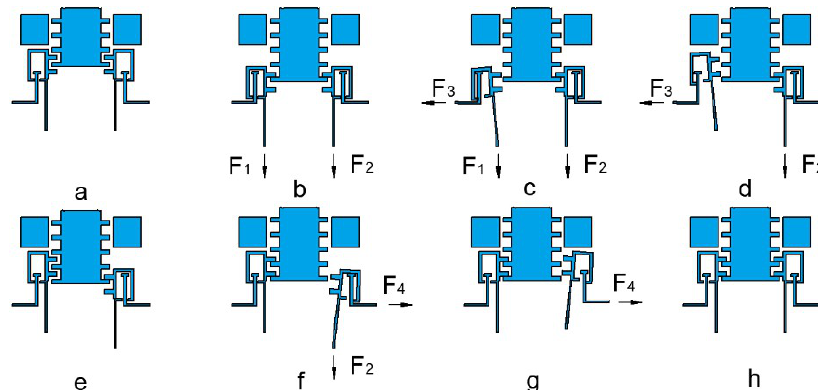
Figure 6. The operation process of the actuation chip. ( a ) Initial state. ( b ) Actuator No.2 and No.3 pull the slider to move one sub‑step. ( c ) Actuator No.1 disengages the left pawl and slider. ( d ) Teeth on the left pawl align with the gap on the slider. ( e ) The left pawl reengages with the slider. ( f ) Actuator No.4 disengages the right pawl and slider. ( g ) Teeth on the right pawl align with the gap on the slider. ( h ) The right pawl reengages with the slider and accomplishes one step movement.